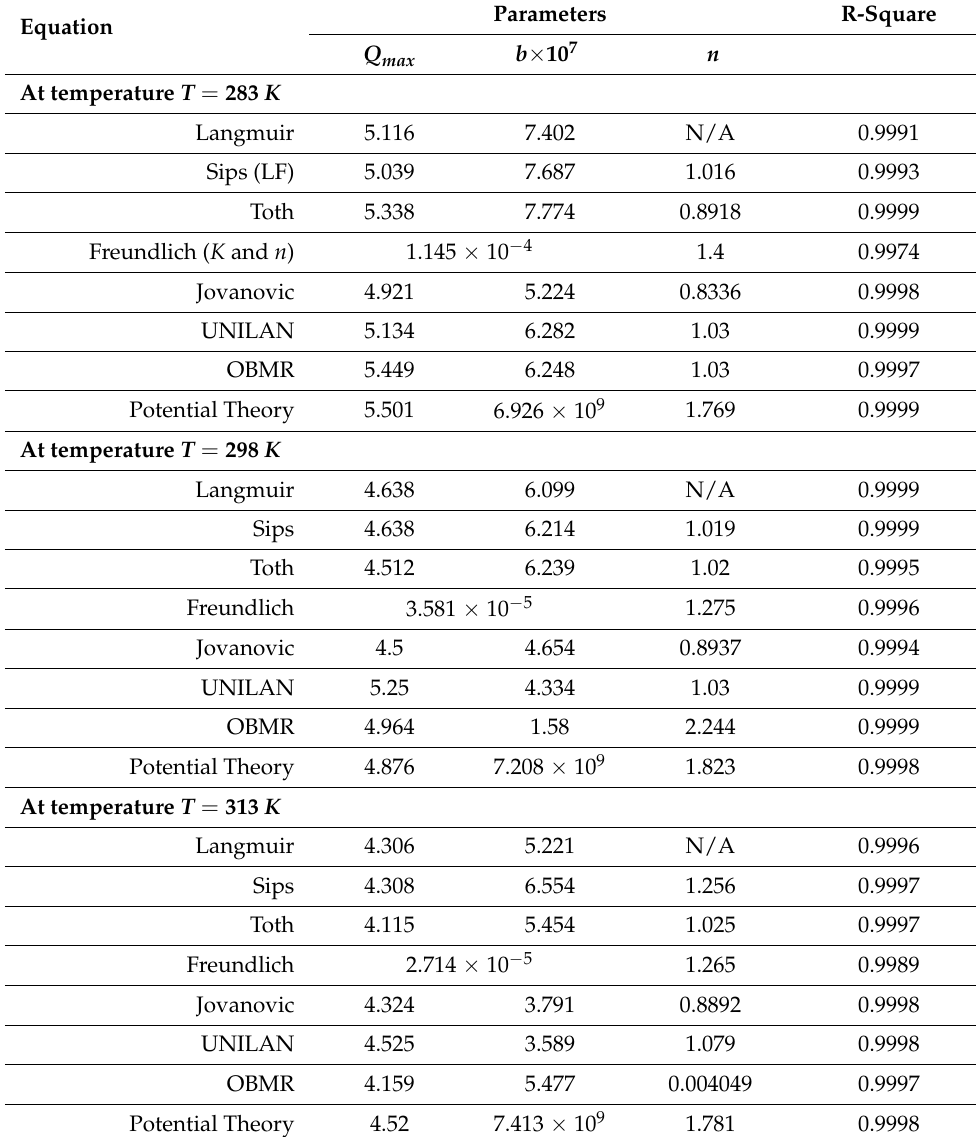
Table A2. Coefficients of the model equations obtained by nonlinear regression of experimental data for the nitrogen gas at different